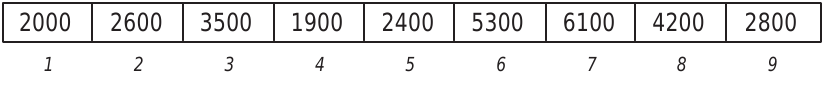
Figure 3. The value vector corresponding to Figure 1 and Figure